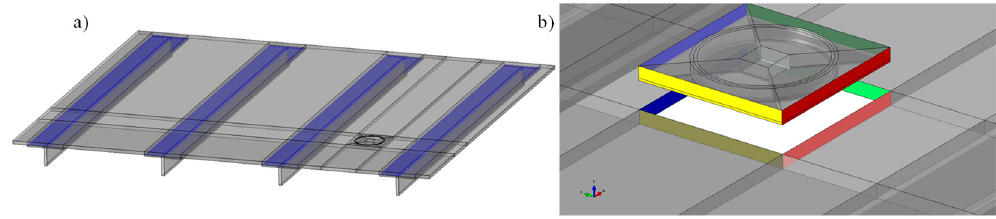
Figure 6. Tie constraints: ( a ) skin - stringer bonding and ( b ) global-local interfaces.